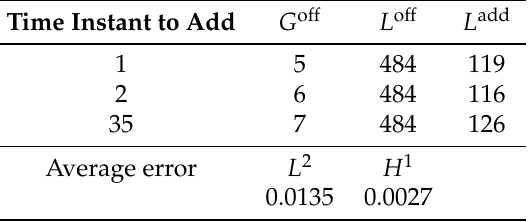
Figure 7. Relative errors advancing in time for the adaptive POD. Table 1. Adaptive-POD-1 with 5 initial global POD